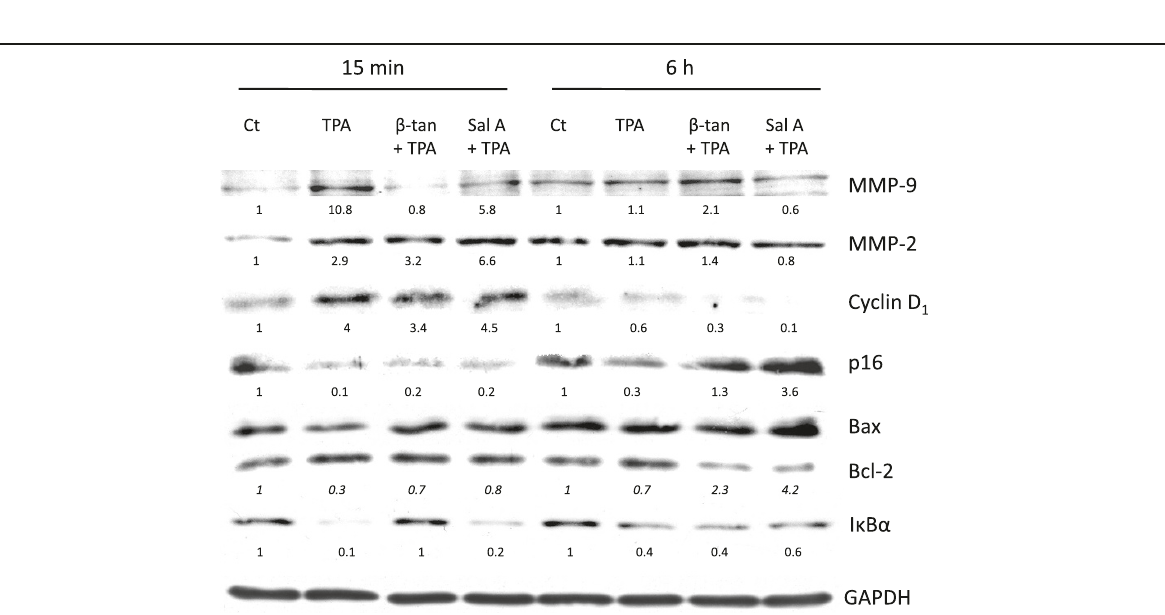
Figure 5 β -tan and Sal A modulate the protein levels of key AP-1 and NF- κ B downstream target genes in JB6P+cells. JB6P+cells were plated in 100 mm dishes at a density of 50,000 cells/ml. At 80 – 90% confluency, cells were starved with 0.1% FBS for 24 h, then were pre-treated with either 10 μ g/ml β -tan or 15 μ g/ml Sal A for 1 h, followed by 15 min or 6 h TPA treatment. Whole cell proteins were immunoblotted with the indicated antibodies and reprobed with GAPDH antibody to ensure equal protein loading. Densitometry values were standardized relative to GAPDH for each condition and results are expressed relative to control (Ct) treated cells for each time point. Densitometry values for Bax:Bcl-2 protein ratios are indicated in italics